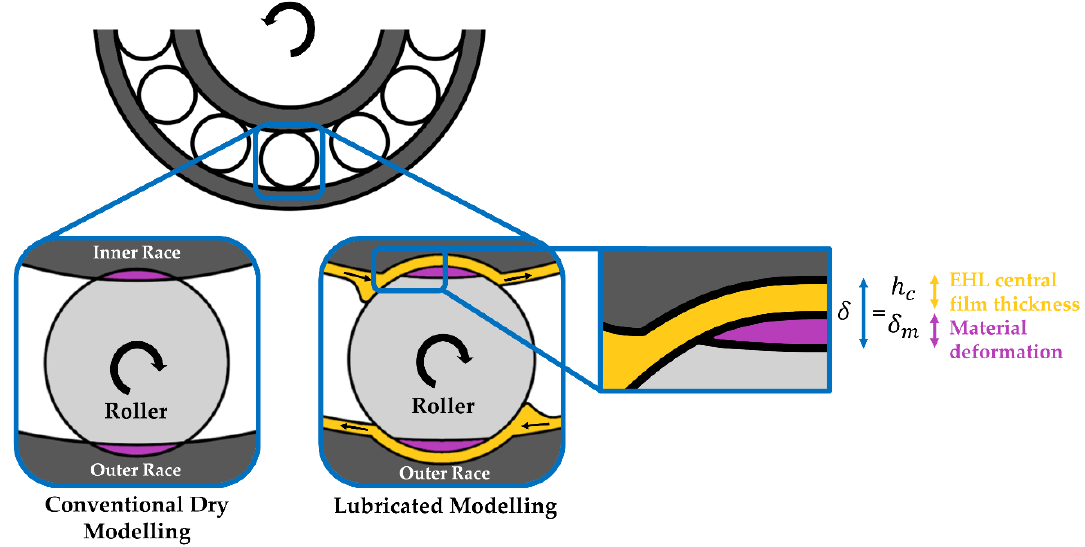
Figure 4. Dry vs. Lubricated Roller – Race Contact.